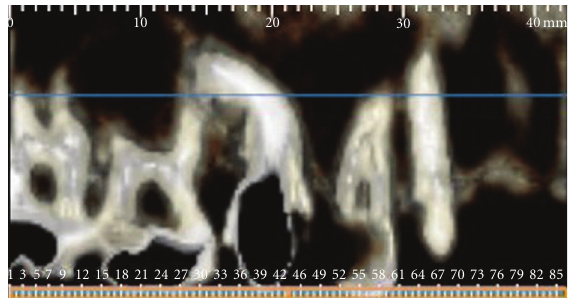
Figure 5: Cone-beam computerized tomography image showing close association between the roots of the maxillary second premolar and first